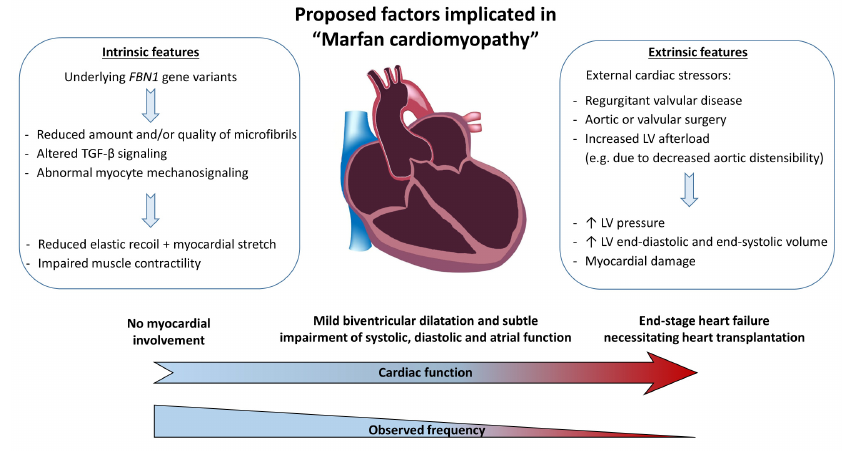
Figure 2. Proposed factors implicated in “Marfan cardiomyopathy”. FBN1: fibrillin-1 gene, TGF- β : transforming growth factor-beta, LV: Left ventricular.